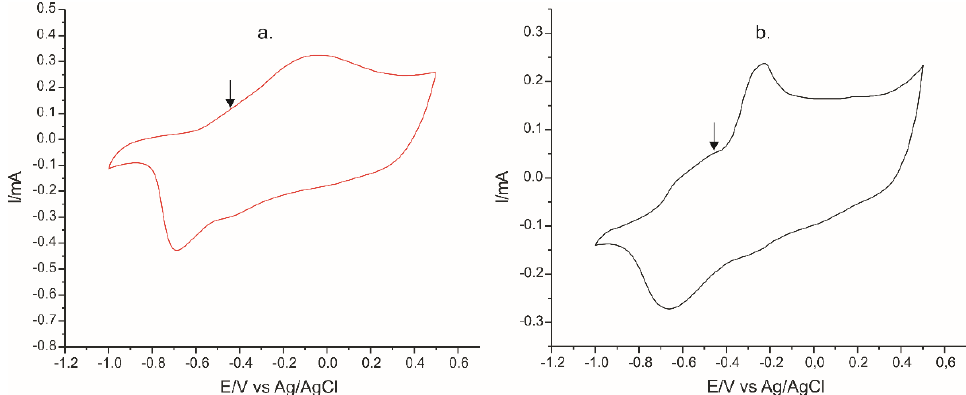
Figure 12. Voltammetric responses of the PPy/FeCN sensor in a solution of: ( a ) L-Tyrosine (SOLARAY); ( b ) Cebrium (EVER NEURO PHARMA). Estimated concentration of L-Tyr in the solutions was 10 − 3 M, in agreement with the quantity declared by producers in the pharmaceutical products.